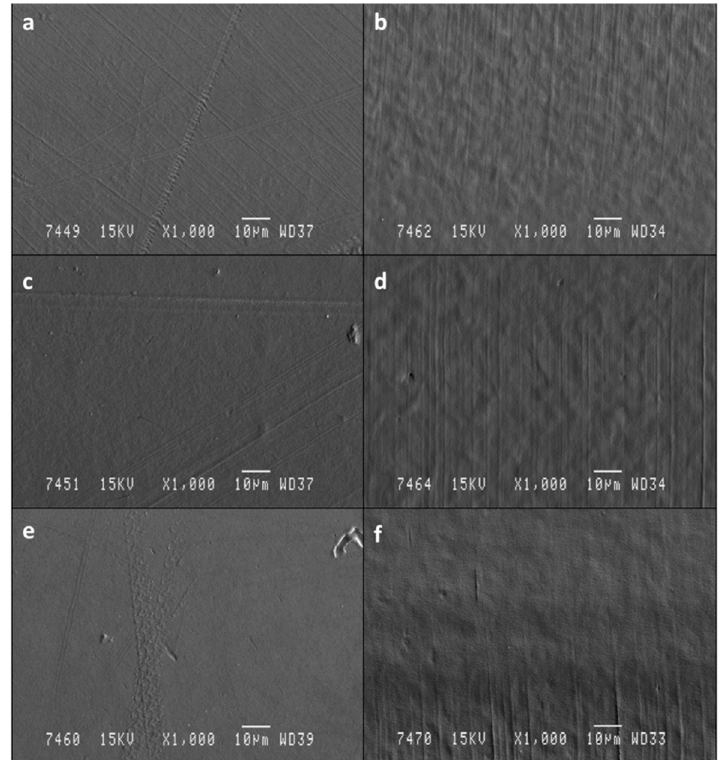
Figure 1. Surface ( a, c, e ) and cross section ( b, d, f ) SEM micrographs (1000×) of films (a, b: neat PCL; c, d: PCL3; e, f: PCL6).